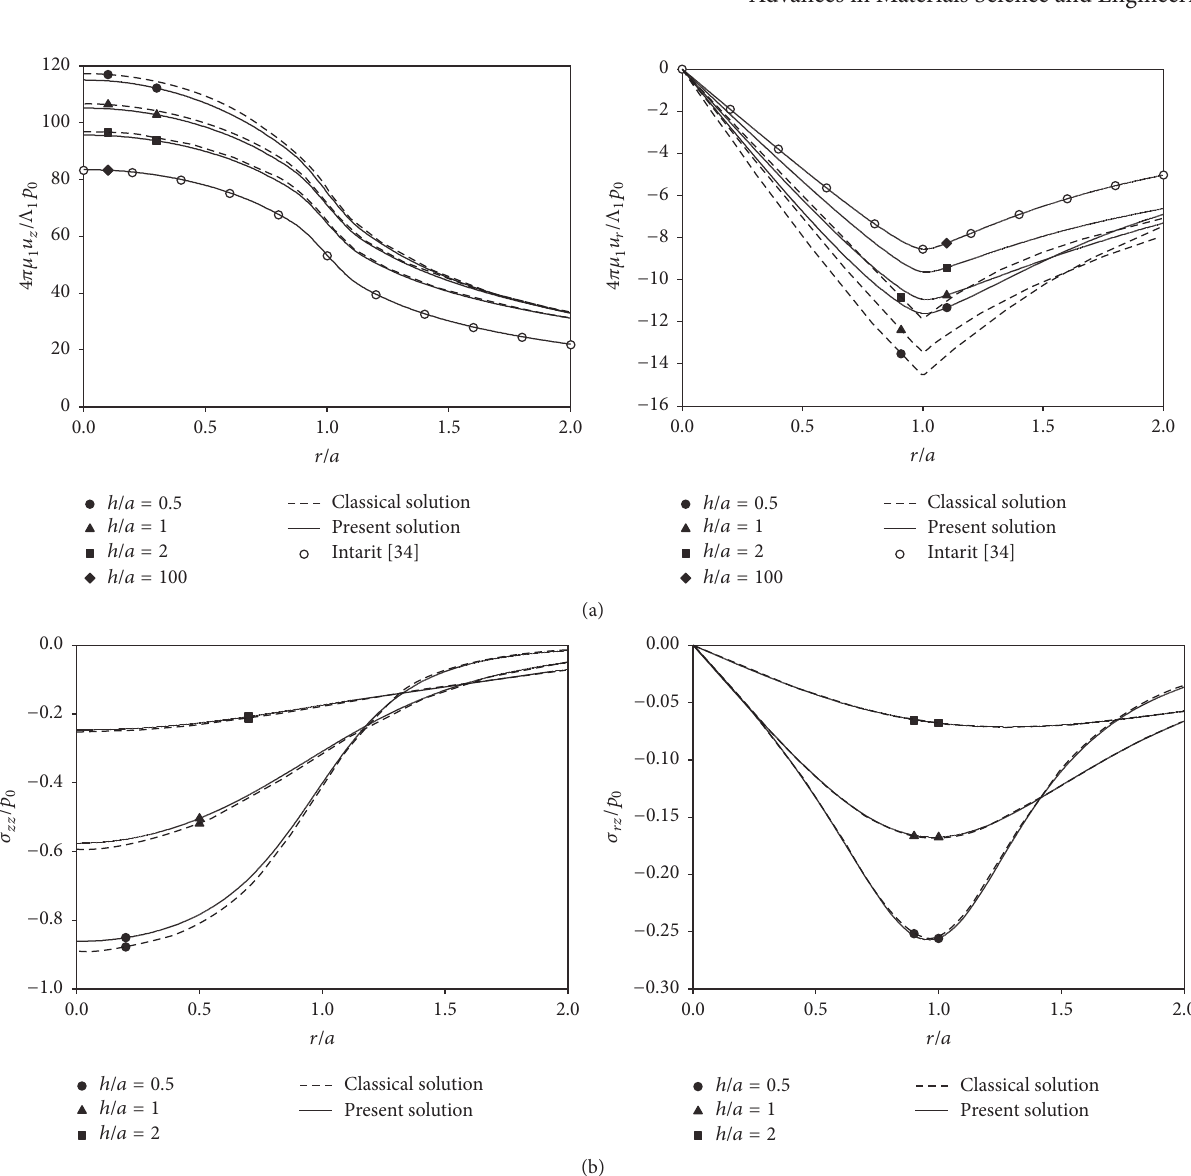
Figure 2: Radial variations of elastic fields under the vertical loading for different values of layer thickness (ℎ/𝑎) : (a) surface displacements (𝑧 = 0) and (b) stresses at the interface (𝑧 = ℎ) .